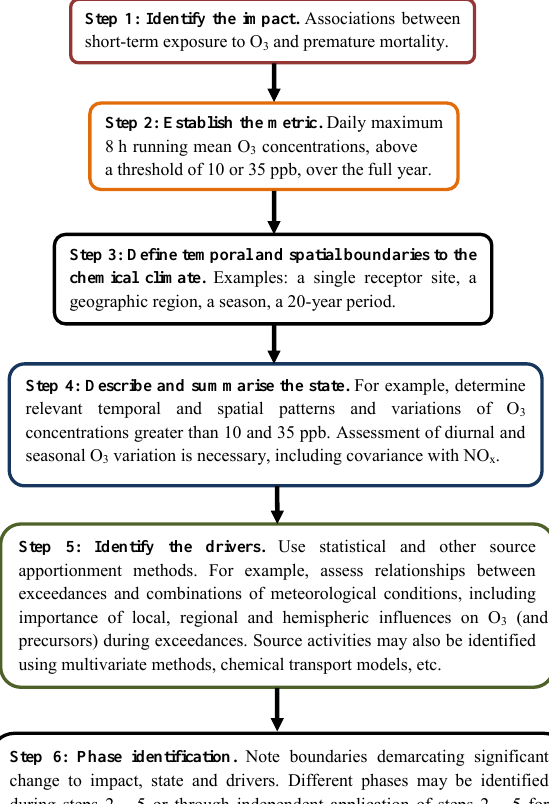
Figure 2. Practical steps for derivation of a chemical climate. The impact of premature mortality associated with short-term exposure to O 3 is used as an example. Text in the chemical climate data sheets is coloured the same as the step which gave rise to the statistic. The details of application of these six steps to the focus of this study are described in Sect.